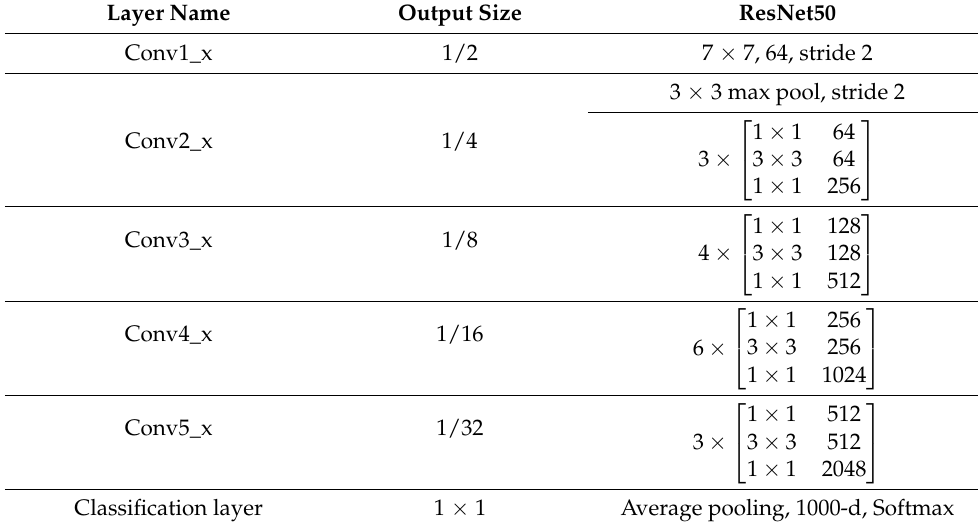
Table 1. Structure of the ResNet50 network.